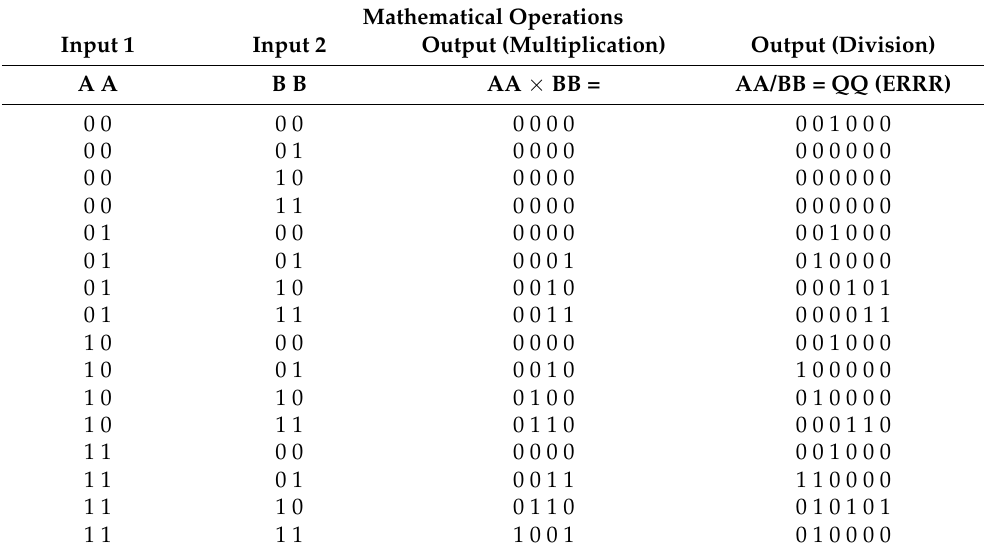
Table 2. Truth table for binary multiplication and division in the case of two 2-bit input values. Input 1 is a 2-bit value labeled AA; Input 2 is a 2-bit value labeled BB. The output value for multiplication is the product of AA multiplied by BB. The output value for division is AA divided by BB; the quotient value QQ is stored in the 2 most significant bits, and the divide-by-zero error bit is the next adjacent bit, while the 3 least significant bits store the unrounded remainder value (RRR). Specific to this case of lower precision, the remainder value is stored in a 3-bit value since the highest possible remainder value is not greater than 7 (base 10 number